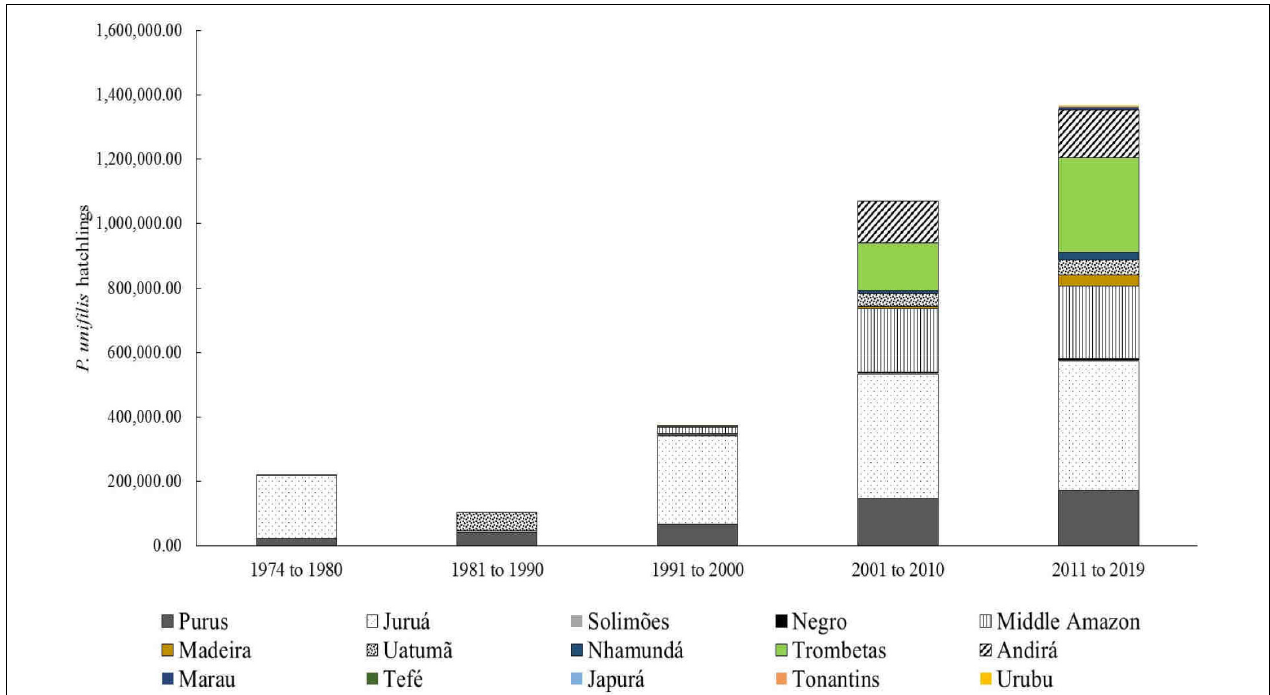
FIGURE 4 | Number of P. unifilis hatchlings protected between 1974 and 2019 for different rivers in the Amazonas state and the northwestern section of the Pará state, Brazil.